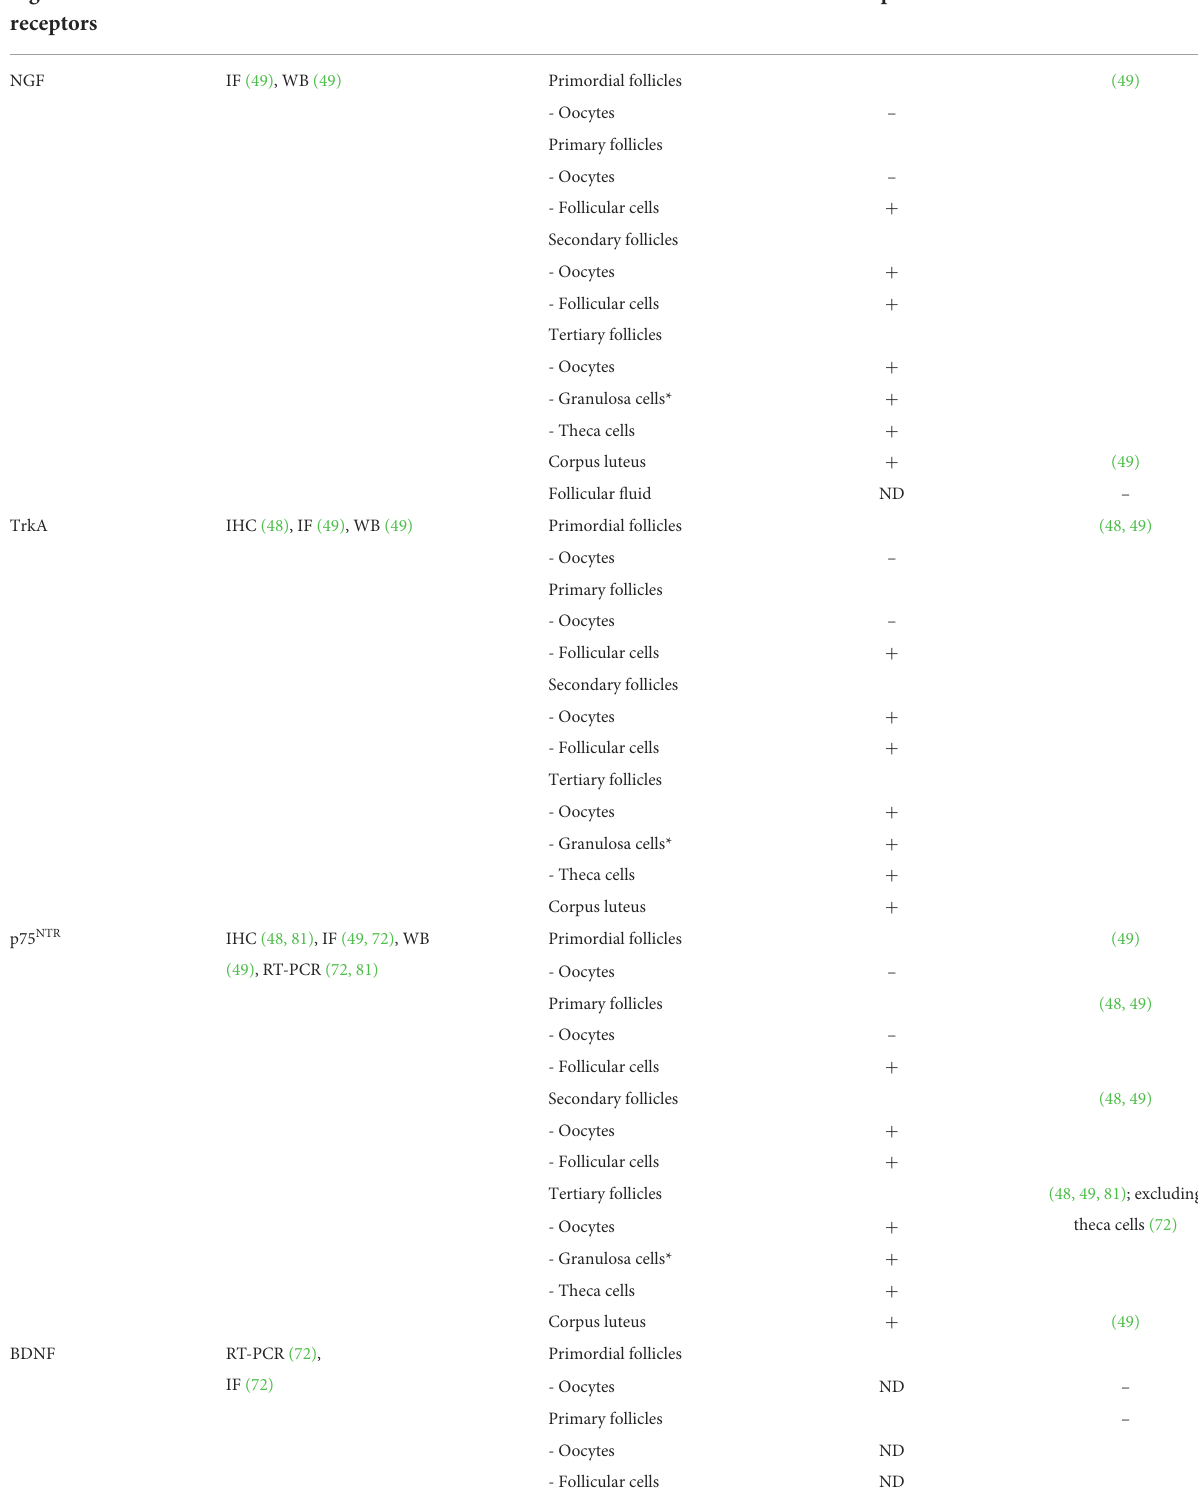
TABLE 1 The identification of various neurotrophic factors and their receptors in the porcine ovary. Ligands or Detection methods Localization receptors